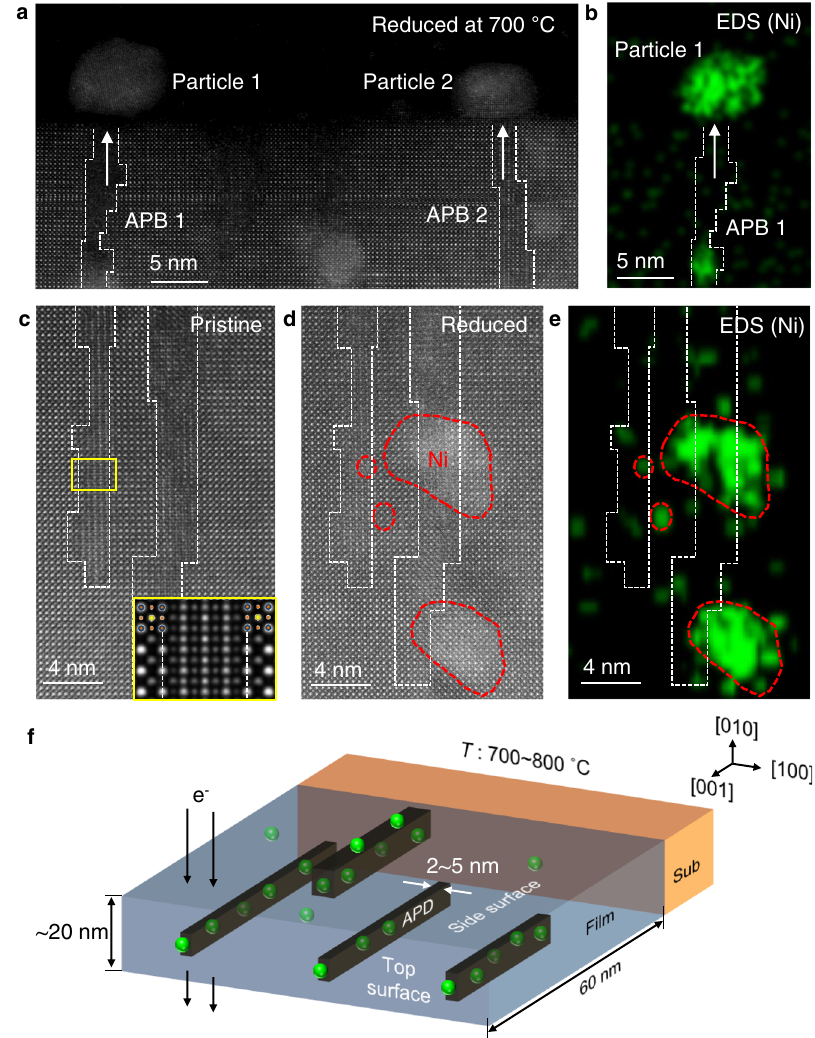
Fig.3|InsituSTEMobservationofNPformationbyexsolutionofNiinthenon- stoichiometric LSNT fi lm. a Cross-sectional STEM-HAADF image and b the cor- respondingNiEDSmapofnon-stoichiometric60nmthick fi lmafterheatinginside STEM.Magni fi edSTEM-HAADFimages c beforeand d afterinsituheating. e NiEDS mapof d showingthepreferentialformationofNiNPsatAPBs.APBsareoutlinedby white dashed lines. The inset in c represents the simulated APB model in good agreement with the experimental image. The complicated STEM-HAADF image